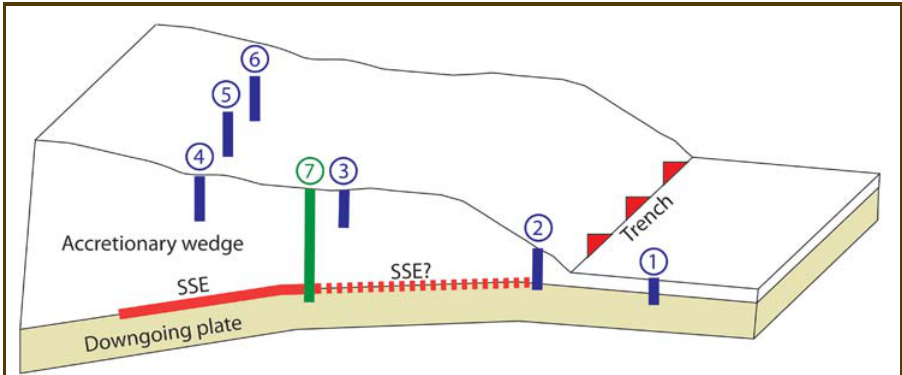
Figure 3. Schematic illustration (not to scale) of a drilling and borehole monitoring scheme which could be applied to address primary SSE questions. See workshop report for further details on the transect design. Note that holes 5 and 6 are positioned off the main transect and are intended for basic monitoring to constrain off-transect variation in SSE behavior. Red patches on the subduction interface show where SSE slip is constrained from onshore instruments. The position of the deep riser hole (#7) should be constrained by current knowledge of the shallowest part of the interface undergoing SSE. In addition to shallow monitoring and sampling of the upper plate, Site 3 would serve as a pilot hole for the deep riser Site 7. Site 1 is primarily intended to core and log the input section on the subducting plate. The dashed red line shows a possible trenchward continuation of SSE behavior. Offshore instrumentation (borehole monitoring and seafloor geodesy) will be needed to constrain the updip limit of